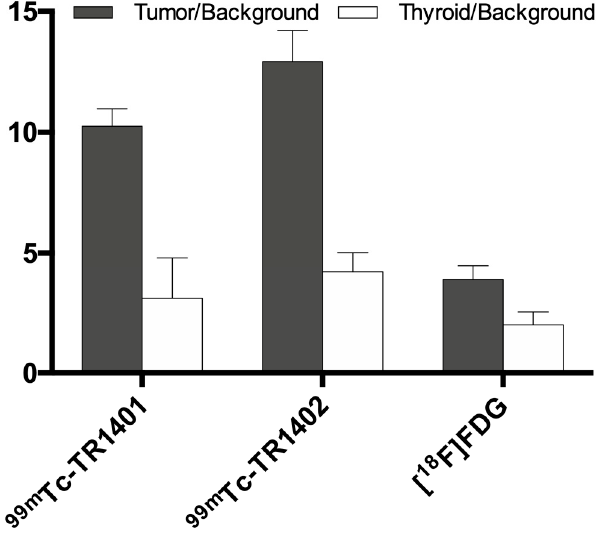
Figure 5. Tumor/background ratio (grey bars, mean ± SD) and thyroid/background ratio (white bars, mean ± SD) of 99m Tc-TR1401, 99m Tc-TR1402, and [ 18 F]-FDG in studied dogs. For tumor/background ratio, the target was chosen on the thyroid nodule in the most representative axial sections; the background, of the same size, has been selected over the vertebral body of the same section. Thyroid/background ratio was calculated drawing a ROI on the contralat- eral lobe. Both 99m Tc-TR1401 and 99m Tc-TR1402 significantly accumulated in the tumor more than FDG ( p < 0.0001), and 99m Tc-TR1402 significantly accumulated more than 99m Tc-TR1401 ( p < 0.0001). The same applied when comparing tumor/background vs. thyroid/background ratios (all p < 0.0001). No significant differences were found when comparing thyroid/background ratios of different